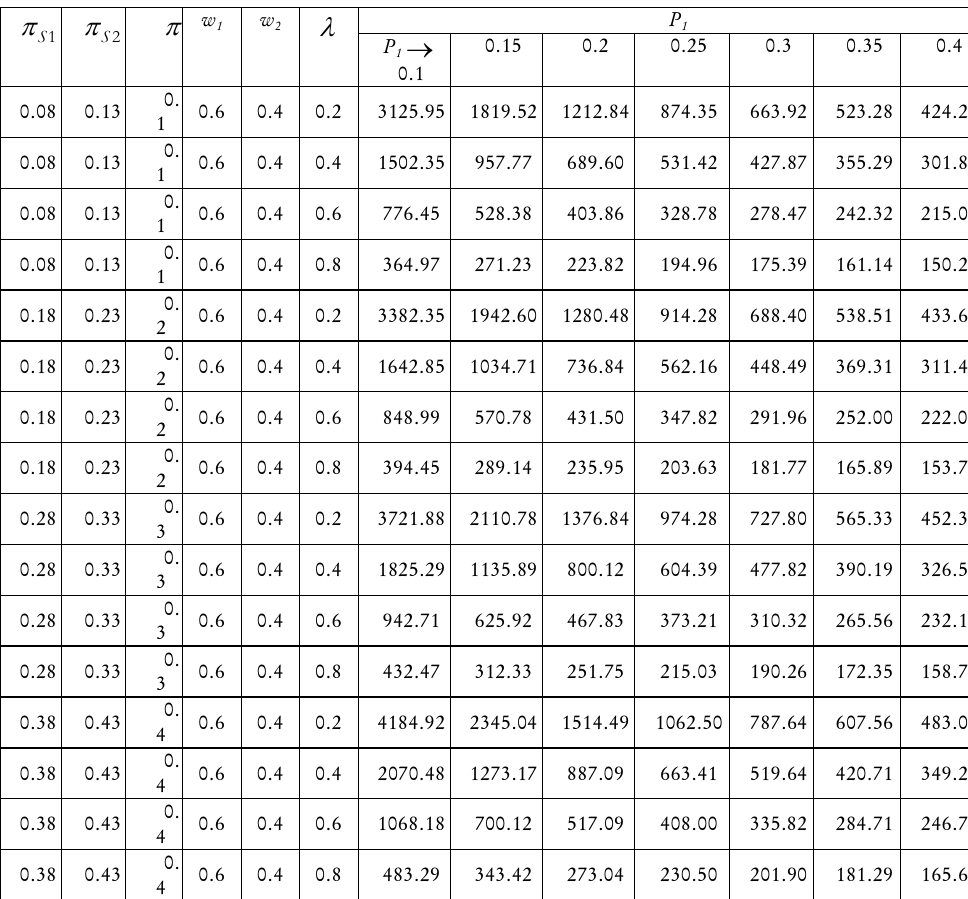
π with respect to Kim and Warde’s (2005) c π estimator ˆ kw